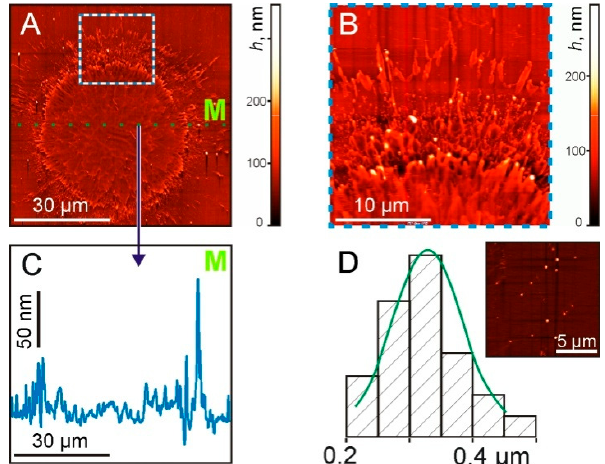
Figure 7. AFM images of the sapphire plate surface after the laser pulse exposure at the same laser parameters as in previous figures. ( A ) General view of the surface. ( B ) The enlarged part at the border area (marked by the square in ( A )). ( C ) Cross-sectional profile along the dotted green line M in ( A , D ). The size distribution of TiNP. On the inset—a surface area with nanoparticles.